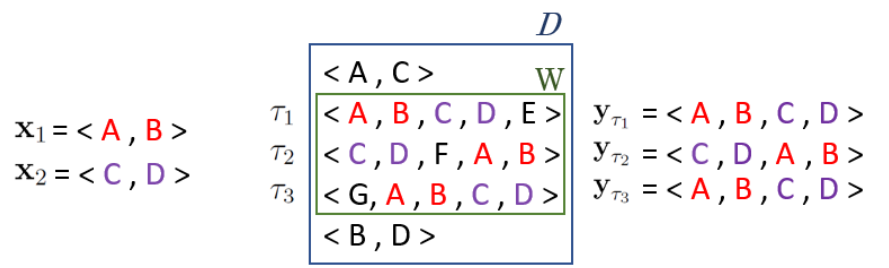
Figure 1. Graphical representation of the case CS W ( D ) = 2. Sequences x 1 and x 2 are closed sequences in D with the same support set W